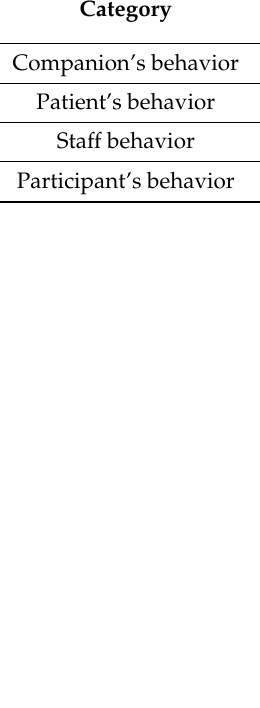
Table 4. Logistic regression model to predict exposure to workplace